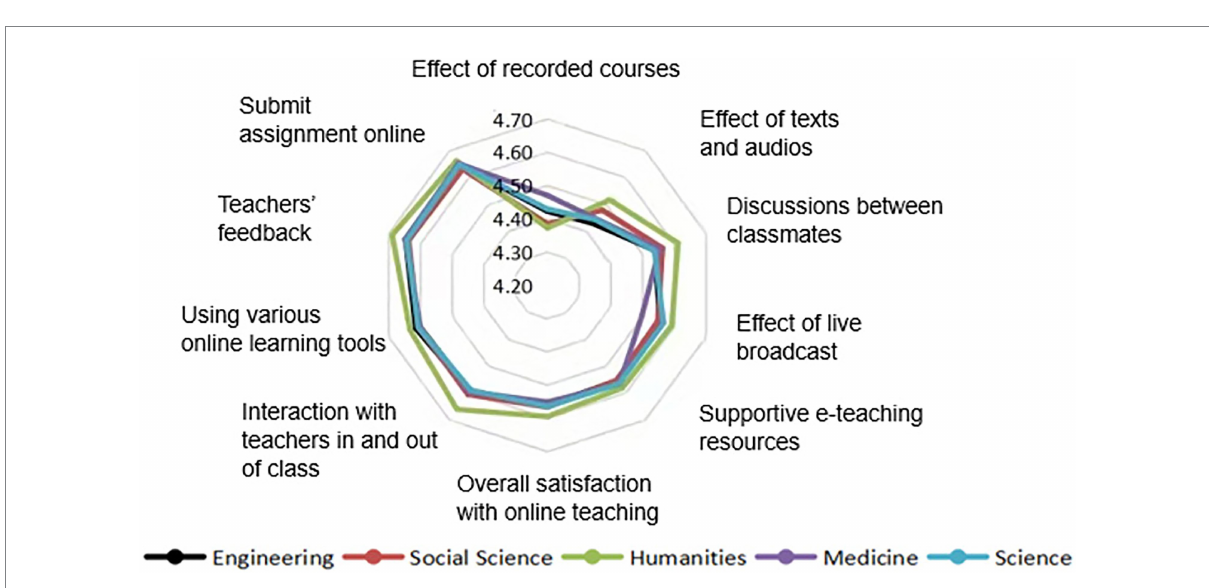
FIGURE 9 Evaluation of online learning by students of different